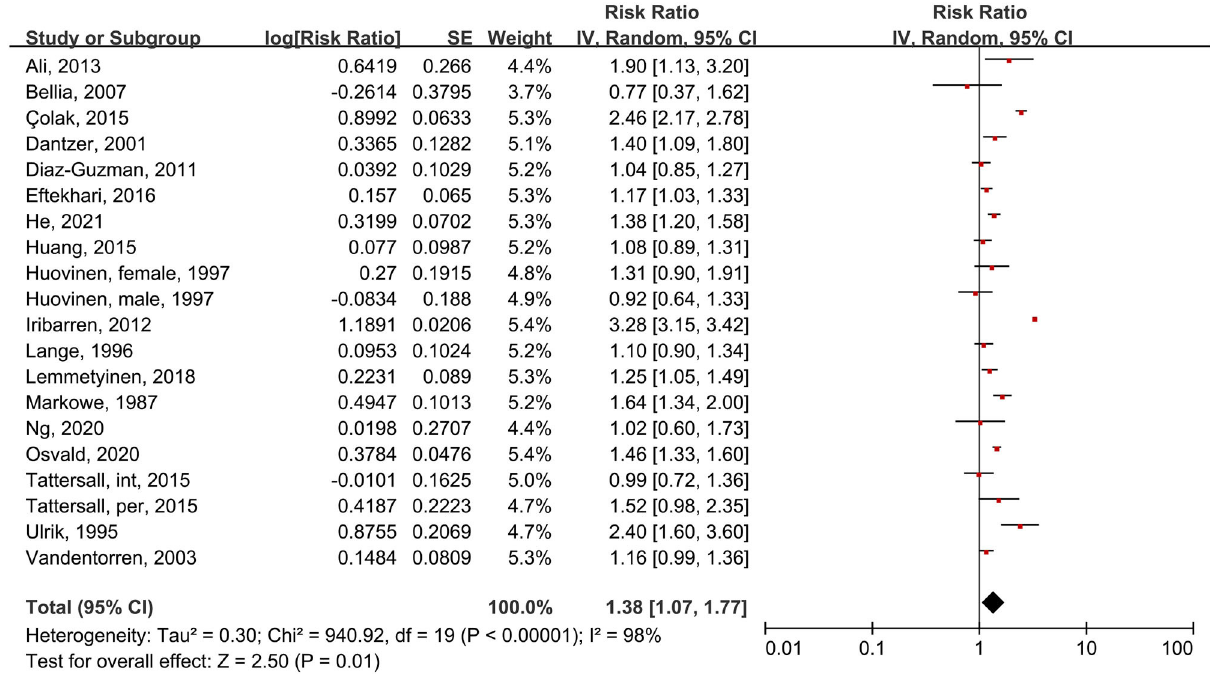
FIGURE 2 | Forest plot shows association between asthma and all-cause mortality. SE, standard error; IV, Inverse Variance method; df, degrees of freedom; int, intermittent; per, persistent.